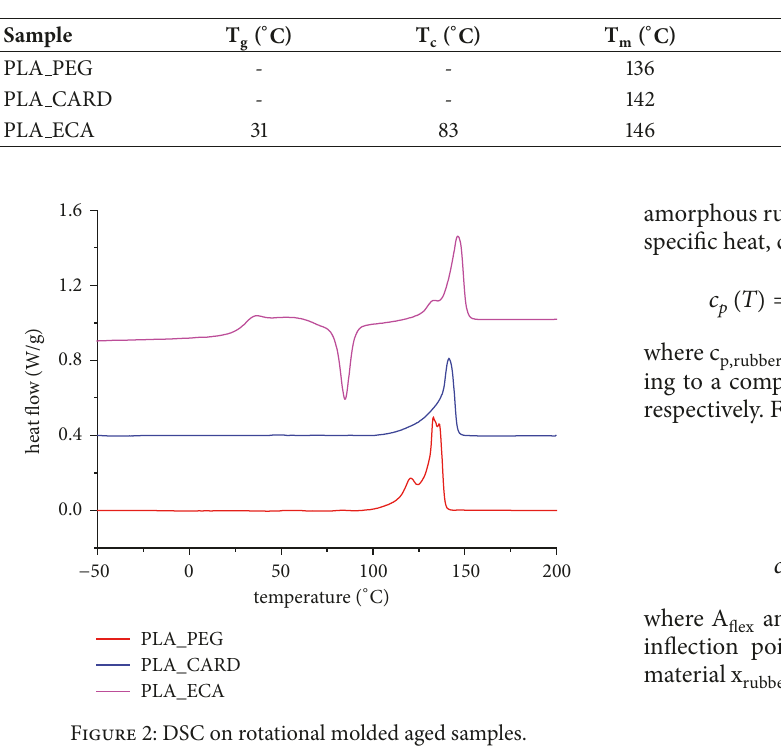
Table 2: Thermal properties of rotational molded aged PLA.